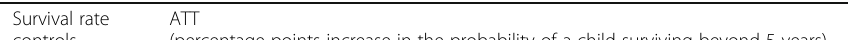
Table 3 Matching using stratification